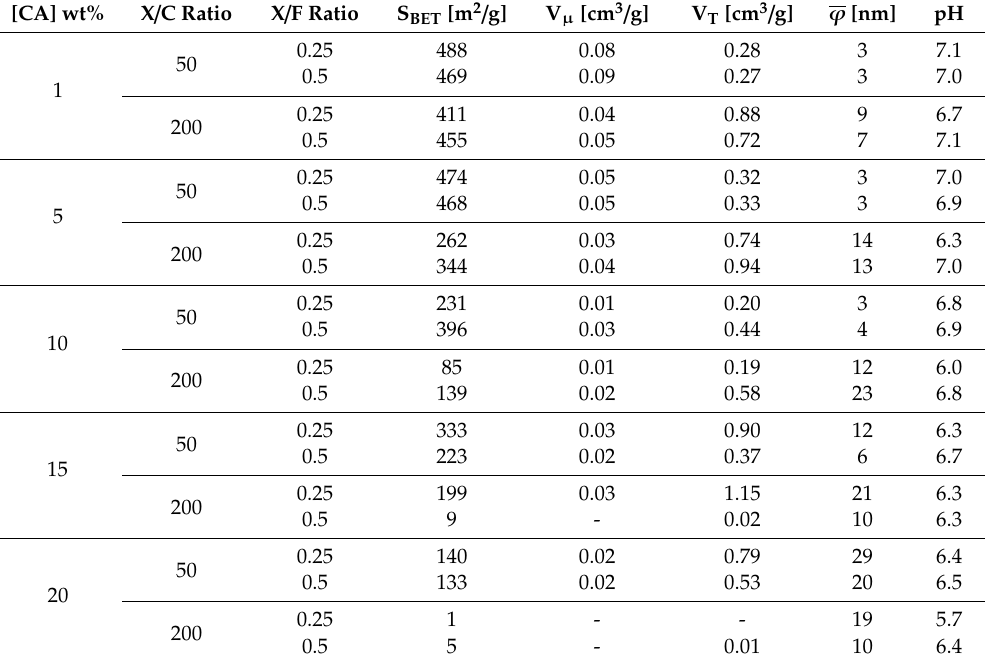
table as all values are reported to an accuracy less than the largest error for each variable. Table A3. Textural properties and initial reaction mixture pH values for gels with cyanuric acid as the